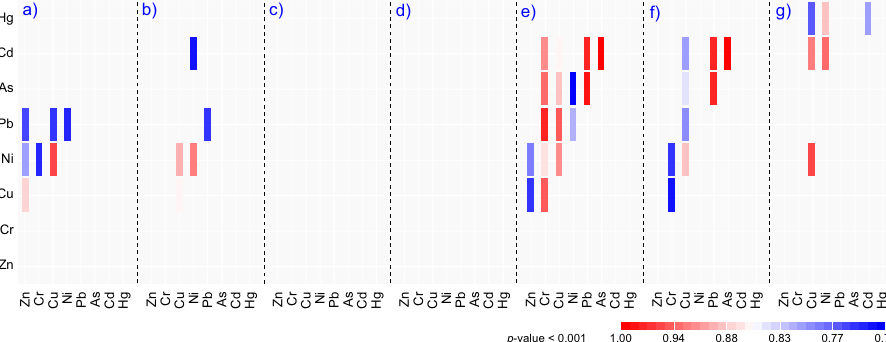
Fig. 4 Signi fi cant Pearson ’ s correlation diagram ( p < 0.001) of heavy metal concentration from the Olt River basin in the 19 sites investigated. a 2018 March, b 2018 May, c 2018 June, d 2018 October, e 2019 May, f 2019 July, and g 2019